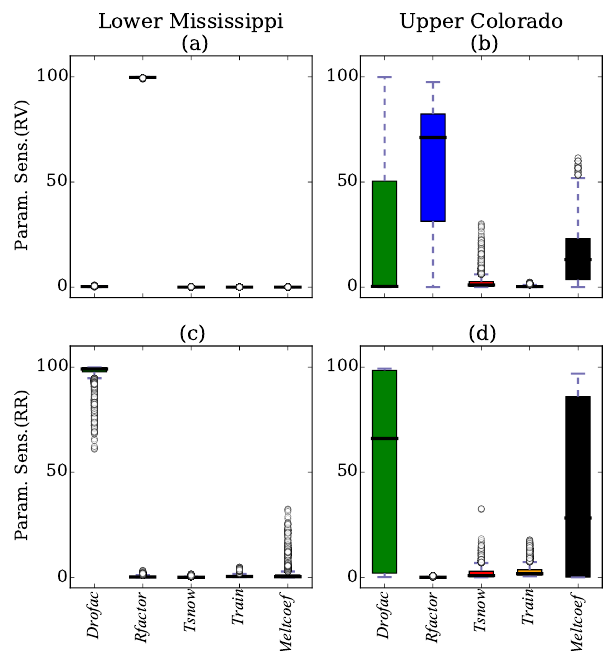
Figure 5. Parameter sensitivities of runoff variability (RV; a and b ) and runoff ratio (RR; c and d ) indices for monthly water balance model parameters in the lower Mississippi (R08) and upper Col- orado (R14).